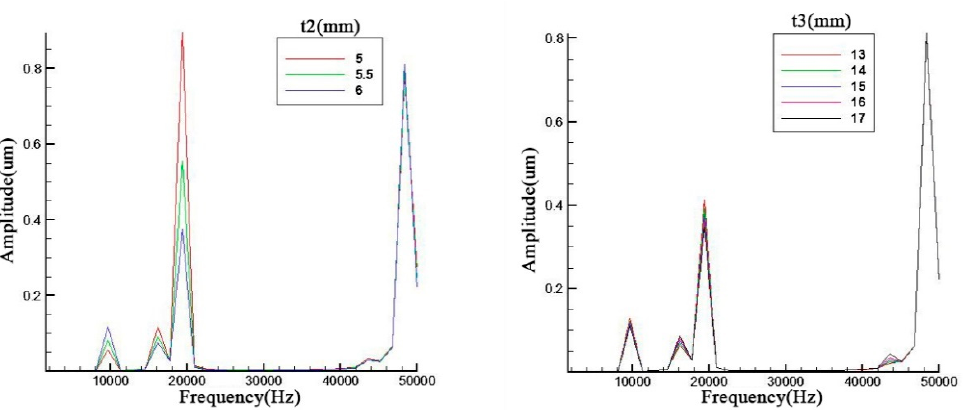
5 of 11 Figure 4. Parameter analysis of h1 , r0 , r1 , and t1 . With an increase of the cavity depth, the cavity diameter and the screw diameter, the resonance frequency decreases slightly and the amplitude of the odd orders also display a decrease. As for the metal endcap, the endcap thickness will prominently influence the 4th order resonance frequency.